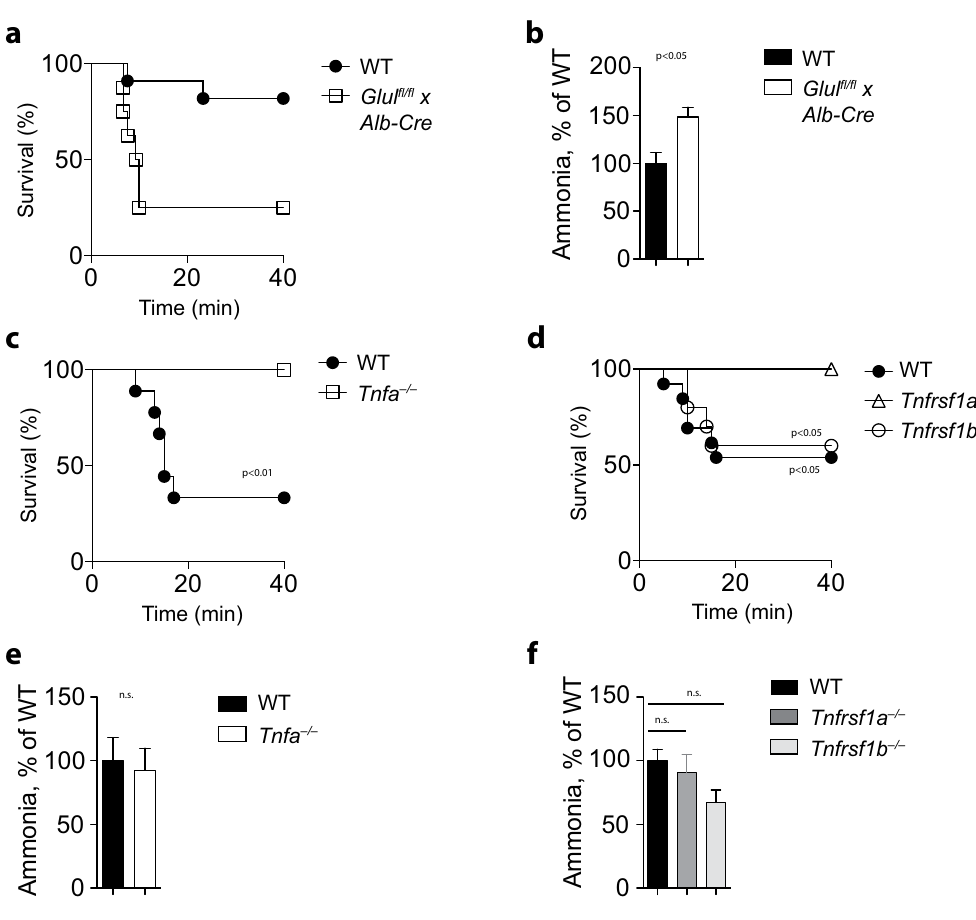
Figure 4. Tnfa − / − mice are protected against acute ammonia intoxication. (a) WT and Glul fl/fl × Alb-Cre + mice were challenged with 12 mmol/kg ammonium acetate in PBS following monitoring of survival (n = 8–11). (b) WT and Glul fl/fl × Alb-Cre + mice were challenged with 8 mmol/kg ammonium acetate in PBS, ammonia levels were measured in blood samples harvested from the retro-orbital venous sinus (n = 5–6). (c) Survival was monitored in WT and Tnfa − / − mice after challenge with 14 mmol/kg ammonium acetate in PBS (n = 8–9). ( d) WT, Tnfrsf1a − / − , and Tnfrsf1b − / − mice were challenged with 14 mmol/kg ammonium acetate in